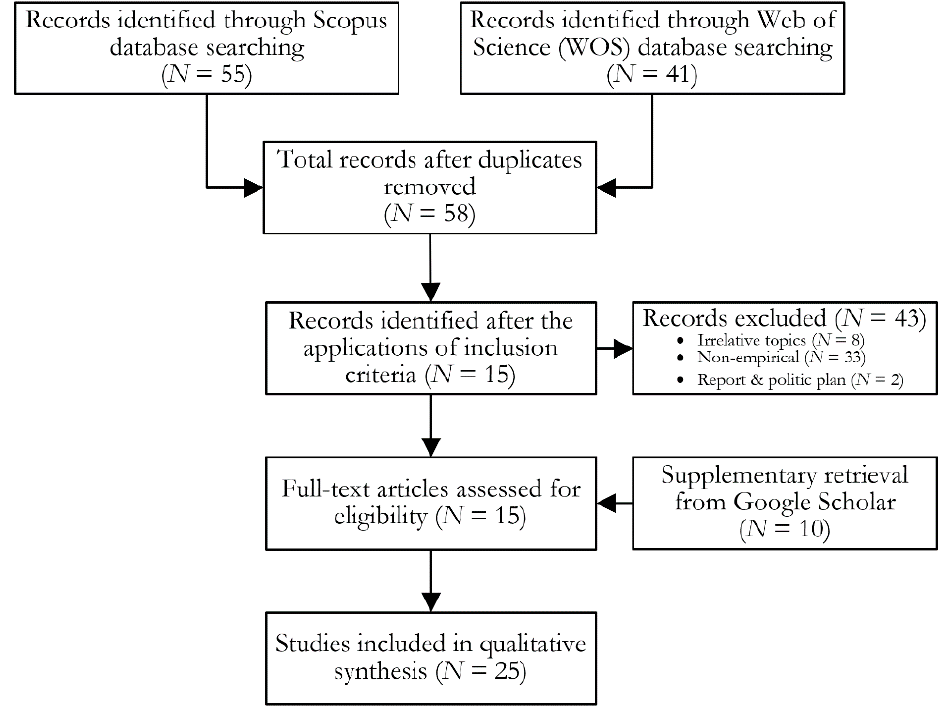
Figure 1. Procedural outline of literature selection.